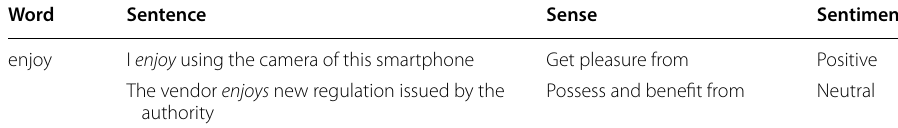
Table 2 Example of different sentiment of the word “enjoy”